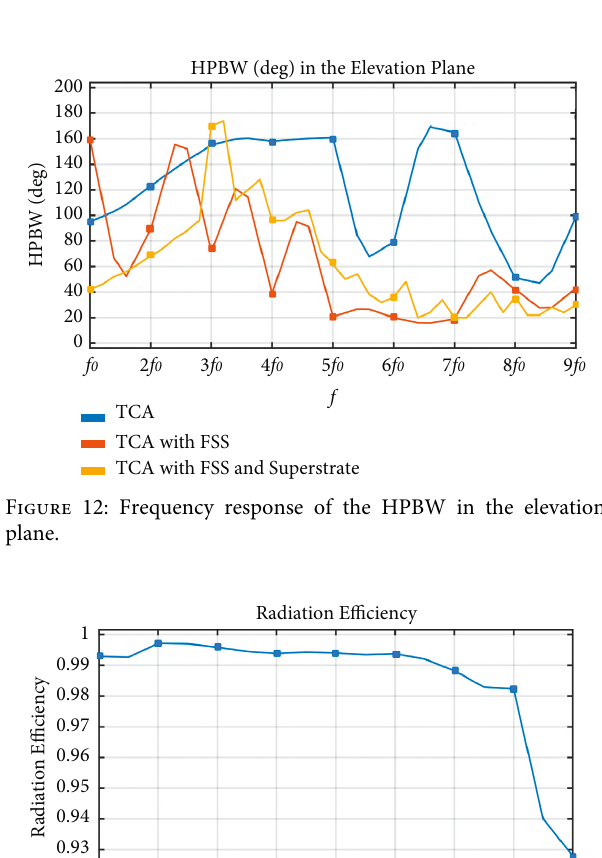
Figure 11: Frequency response of the realized gain ripple in the Azimuth plane.